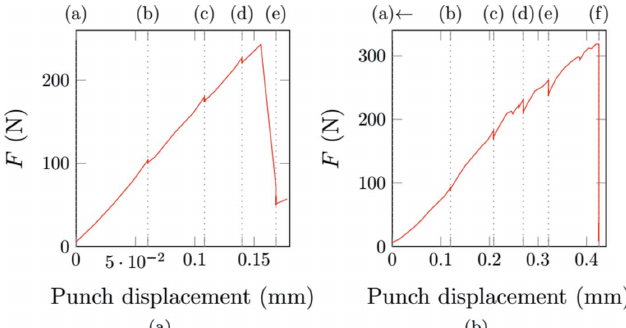
Figure 12 Force displacement curves of the in situ experiments. Letters indicate tomographic and thermographic acquisitions. The punch displacement is re-adjusted as detailed in Appendix A . The test ( a ), at room temperature (20 (cid:2) C), was performed without heating the sample. During the test ( b ), under thermal gradient, the sample was heated, as shown in Fig.